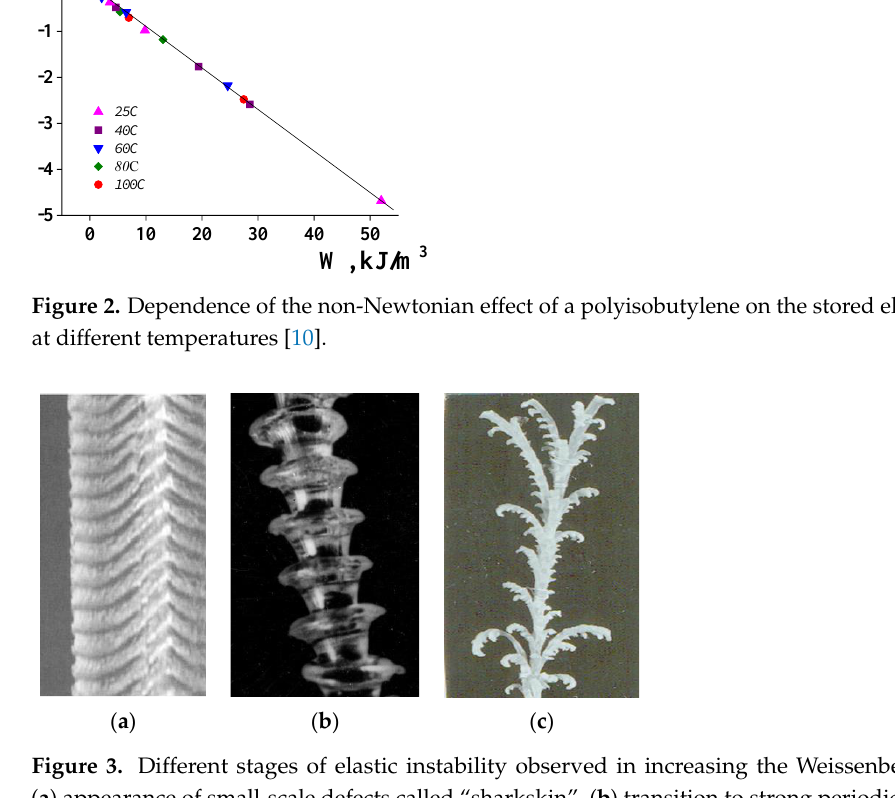
Figure 4. Typical frequency dependences of the components of the complex dynamic modulus for polymer melt (tan α = 2; tan β = 1). It is seen that in the transition to the rubbery plateau (G’ = const) , G” decreases. Then in increasing the frequency, both components of the dynamic modulus increase. Thus, change in dynamic viscosity at increasing frequency is not monotonous, while apparent steady-state viscosity always decreases in increasing shear rate up to the onset of instabil- ity (like in Figure 3). It means the Cox – Merz rule becomes invalid at high frequencies (shear rates) that correspond to the transition to non-linearity due to the flow – rubbery relaxation transition. A similar picture of the linear-to-non-linear transition takes place in extension. Figure 5 shows the deformation rate dependences of the flow and elastic strains expressed by the Henky measure ( H e ) [10 – 12].